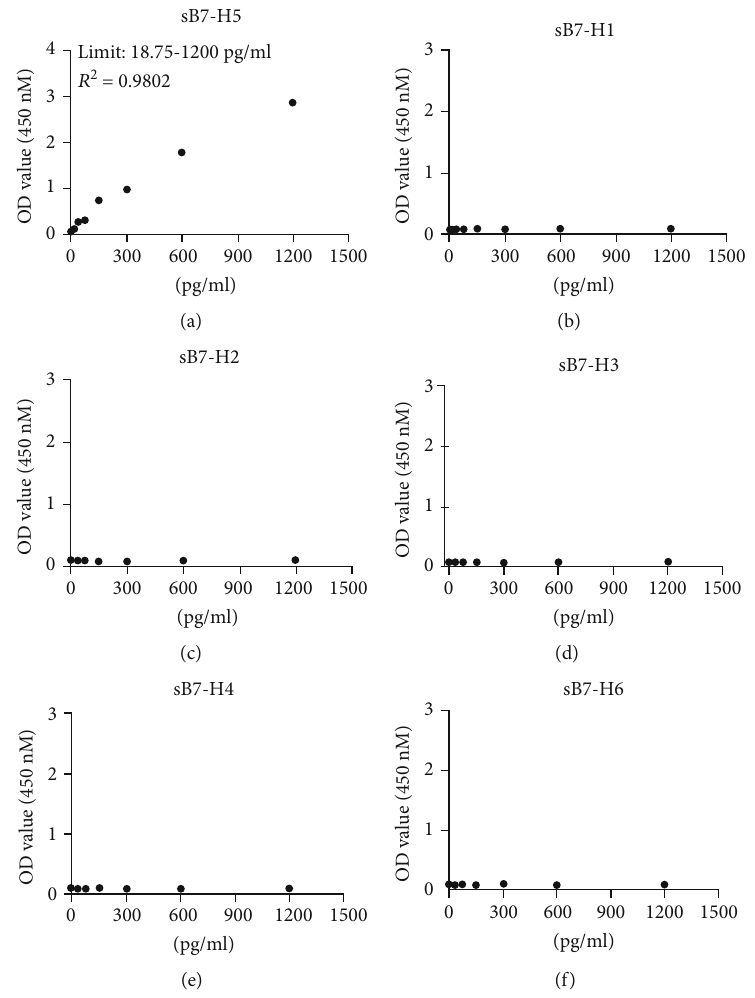
Figure 3: Establishment of sB7-H5 ELISA. (a) The unlabeled 2E5 was 5 μ g/ml, and the biotin-labeled 7B10 was 0.25 μ g/ml. The serial dilutions of the B7-H5 Ig protein starting from 1200 pg/ml were detected by ELISA. R 2 represents the correlation coe ffi cient. (b – f) The speci fi city of sB7-H5 ELISA. The proteins of sB7-H1, sB7-H2, sB7-H3, sB7-H4, and sB7-H6 were detected by Table 4: Precision of the human sB7-H5 ELISA system.